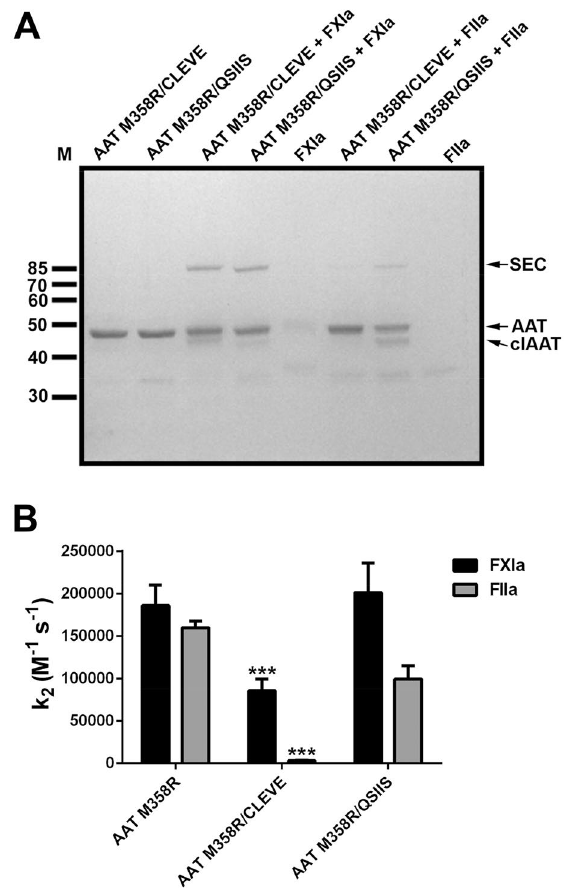
Figure 2. Reactions of AAT P7-P3 motif 2 variants with FXIa and thrombin. Panel ( A ): Electrophoretic assay of reactions of purified AAT M358R/CLEVE or AAT M358R/QSIIS with FXIa or thrombin (FIIa). AAT variants (1.0 µM) were reacted with protease (0.1 µM) for 2 min at 37 °C. Arrows (right) highlight the positions of serpin-enzyme complexes (SEC), uncleaved AAT (AAT), and AAT cleaved in its reactive centre loop (clAAT) on a stained reduced SDS–polyacrylamide gel. M, molecular weight markers are shown at left in kDa. Panel ( B ): Second order rate constants of inhibition (k 2 ) of AAT variants with FXIa (black) and FIIa (grey) are shown as the mean of 3–7 determinations ±